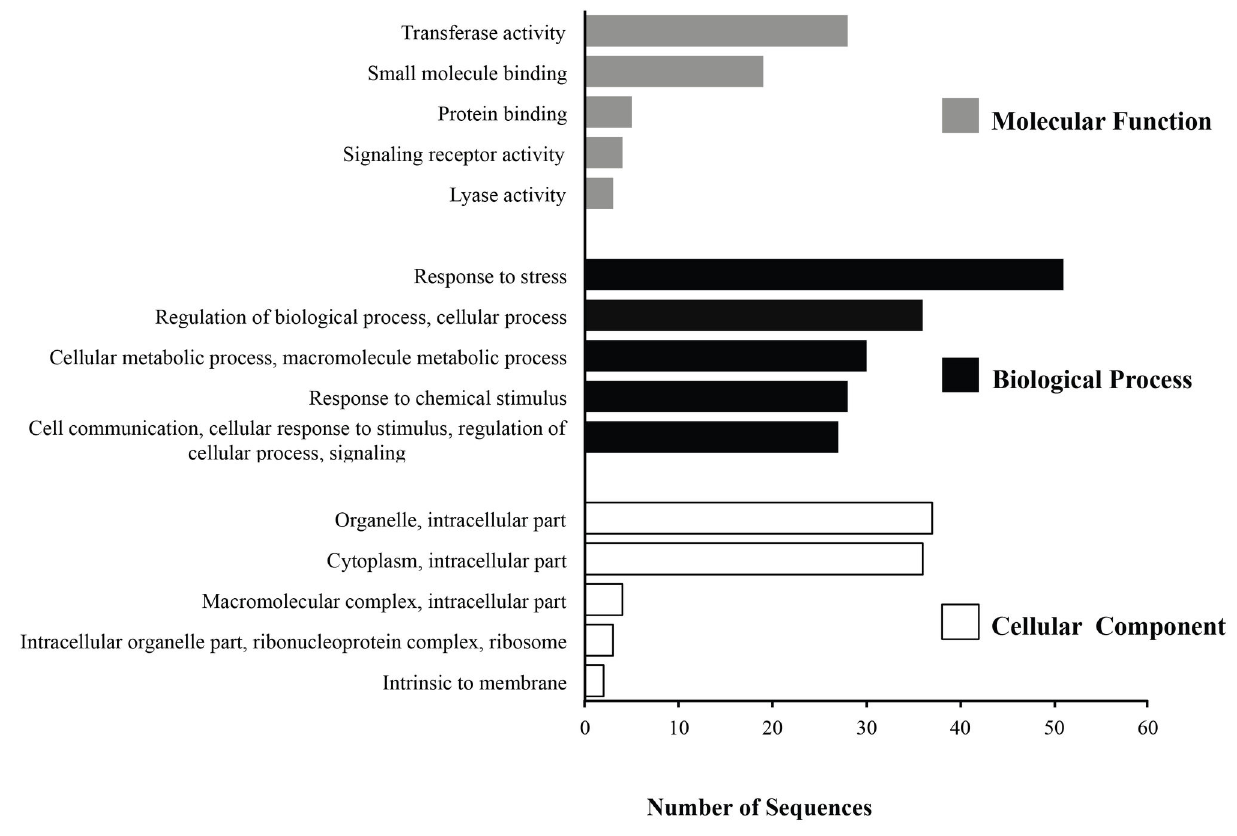
Figure 3. Functional distribution of resistance related isotigs based on gene ontologies: molecular function, biological processes and cellular component in the Cape gooseberry transcriptome. Only major hits are shown (E-value ≤ 1E-4) for each GO category.